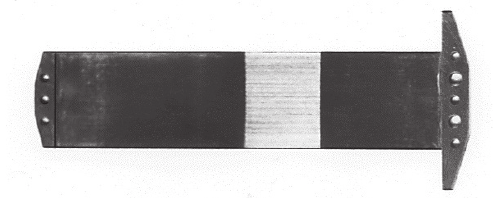
Figure 8. Counterpart after test with smooth shaft specimen High accuracy of measuring the friction coefficient was also provided by using a highly sensitive vibration sensor of the tribometer carriage and using a transmission lever.